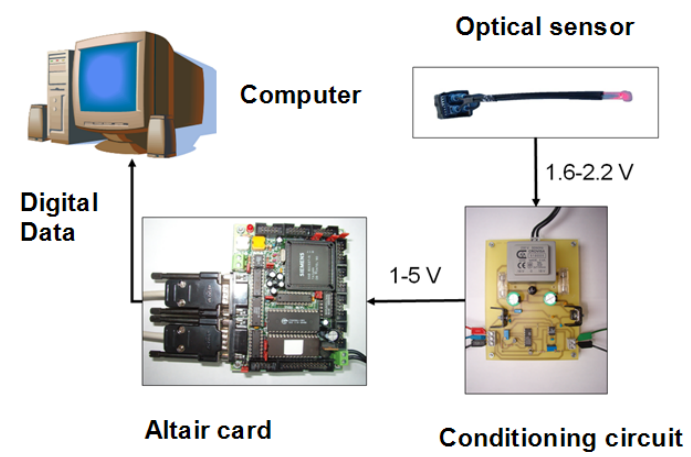
Figure 7. Diagram of the Visualizing system of optoelectronic